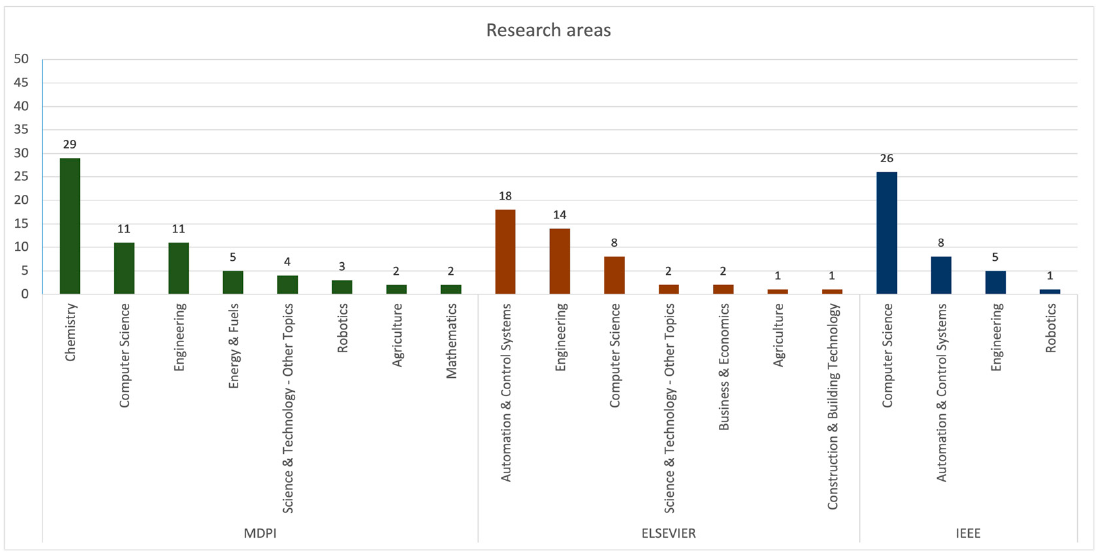
Figure 7. Publishers and research areas.